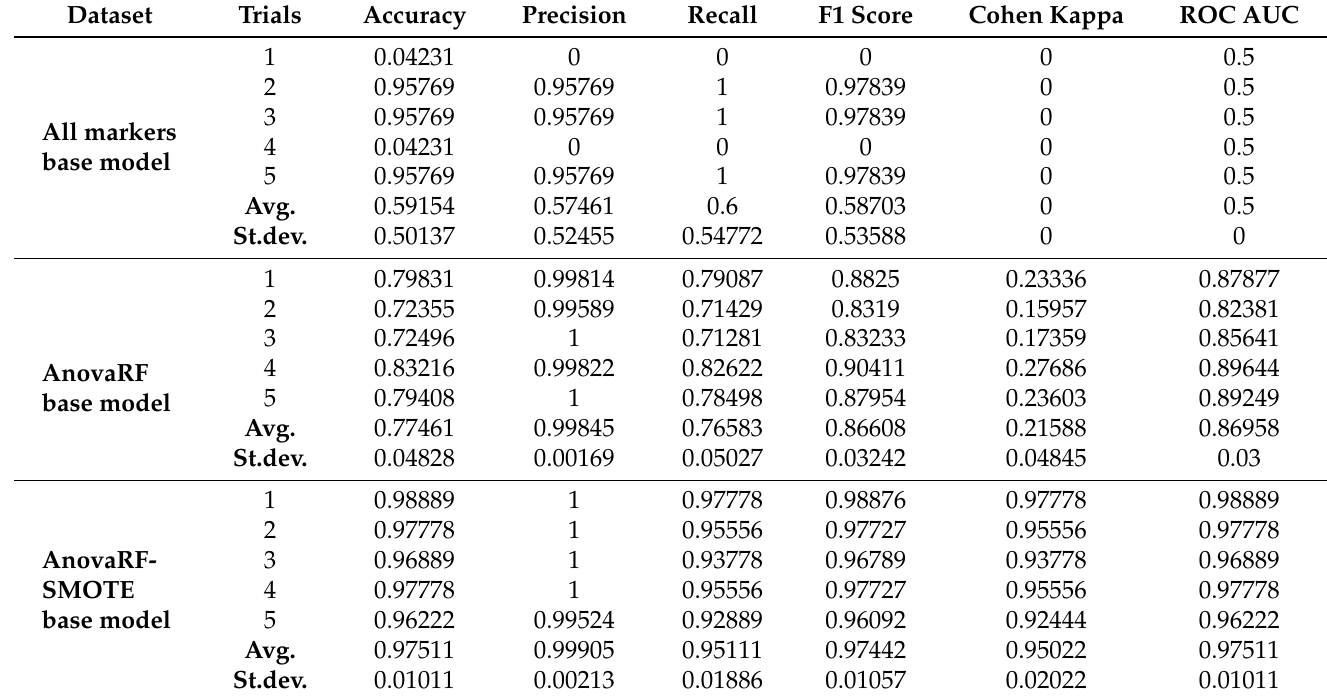
Table A2. Results of deep learning model on 450K dataset using the base model.